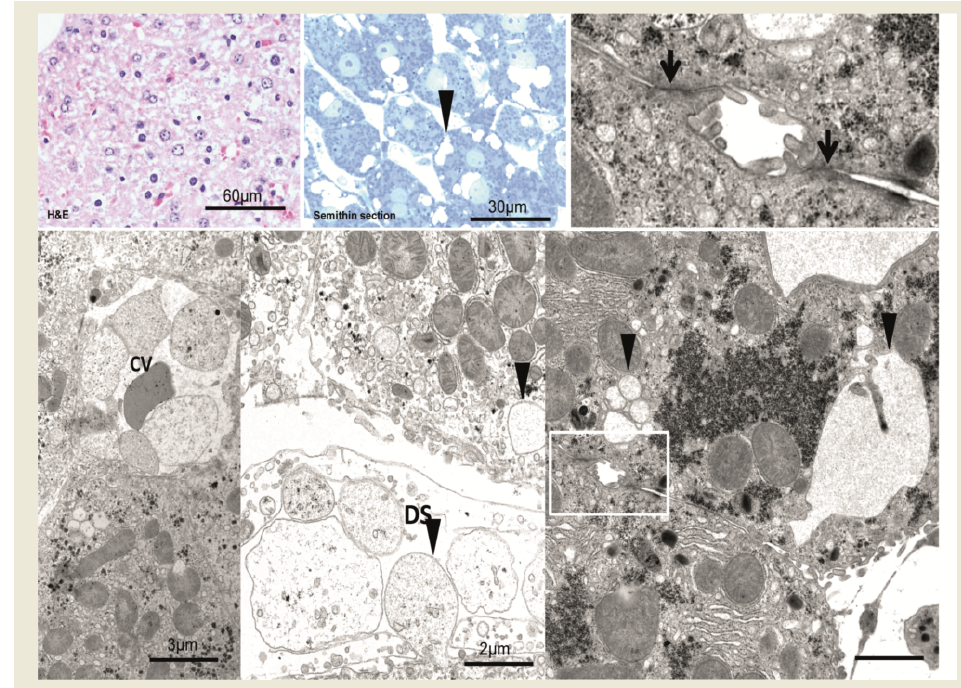
Figure 3. After 1 min, central venules (CV) and perisinusoidal space of disse (DS) are filled with erythrocytes and blood particles (H&E staining). In semithin section and at the ultrastructural level, hepatocytes near the central venule in acinus zone 3 reveal small and larger membrane-bound vesicles in the cytoplasm (arrowheads). Cell membranes and tight junctions (magnified box, lower right and arrows, upper right) are intact. Scale bars are indicated in the respective image.